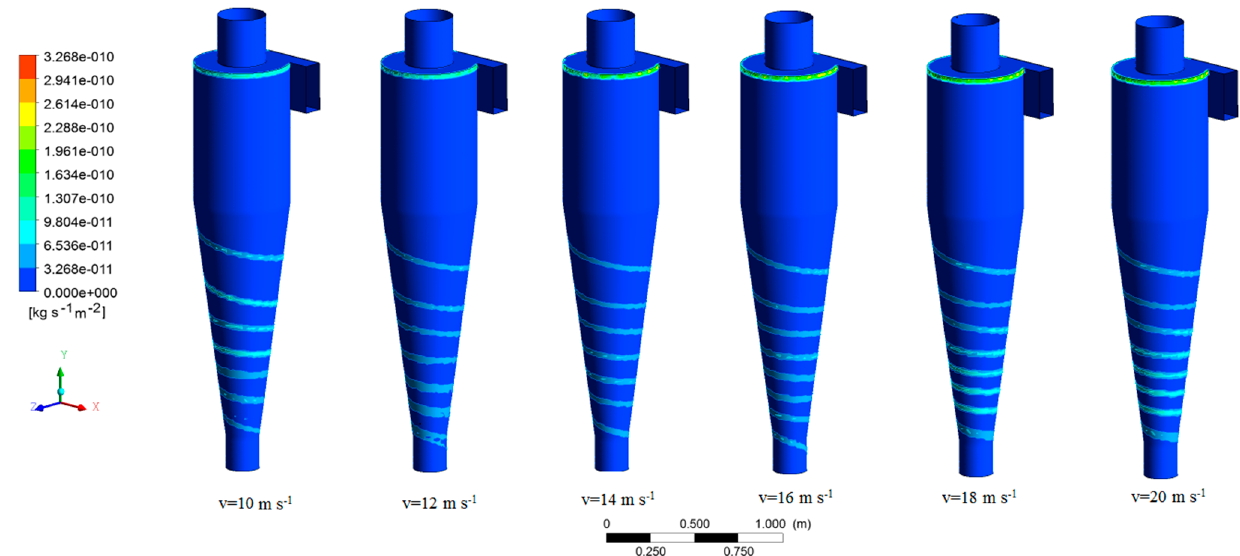
Figure 13. Erosion contours in various inlet velocities.